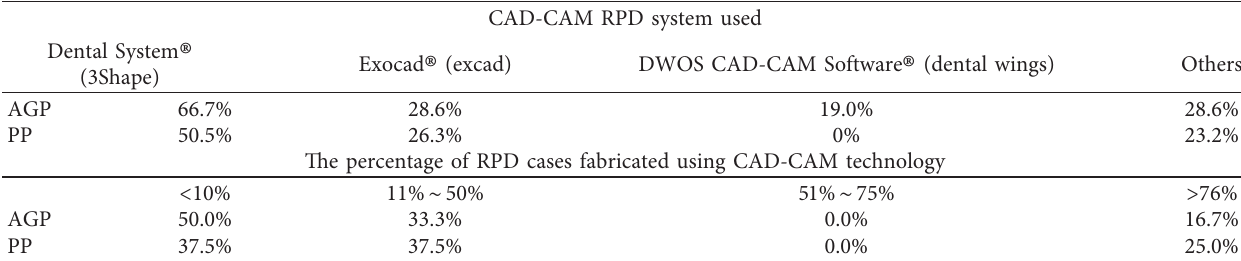
Figure 3: Contents of CAD-CAM partial denture teaching in didactic class, preclinical lab, and clinical practice. PP: predoctoral prosthodontics; AGP: advanced graduate prosthodontics. Table 3: Characteristics of the CAD-CAM RPD system used and